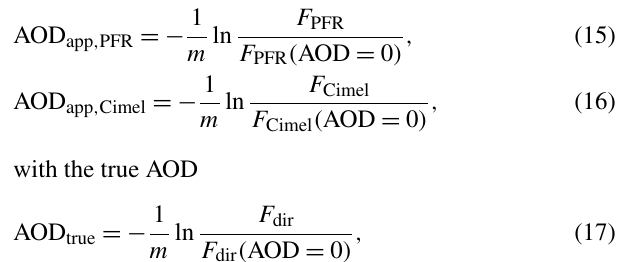
Figure 7. Actual AOD differences between AERONET-Cimel V2 and GAW-PFR versus AOD PFR at (a) 380nm (b) and 500nm for the period 2005–2015. The fitting line has been calculated with those data points with AOD > 0 . 1 and Cimel–PFR AOD difference > 0. The number of data used in the plots is indicated in the legend. The percentage of non-traceable AOD data with these conditions is ∼ 24% for 380nm and ∼ 8% for 500nm. Note that some traceable (black) points show larger AOD differences than non-traceable (red) points because of the air mass dependence of the WMO traceability